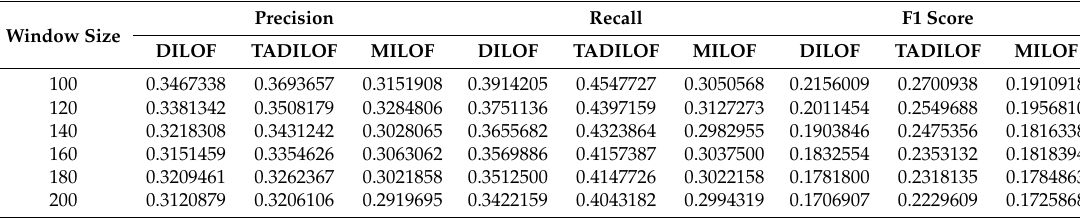
Table 3. Precision, recall, and F1 score on Cardio